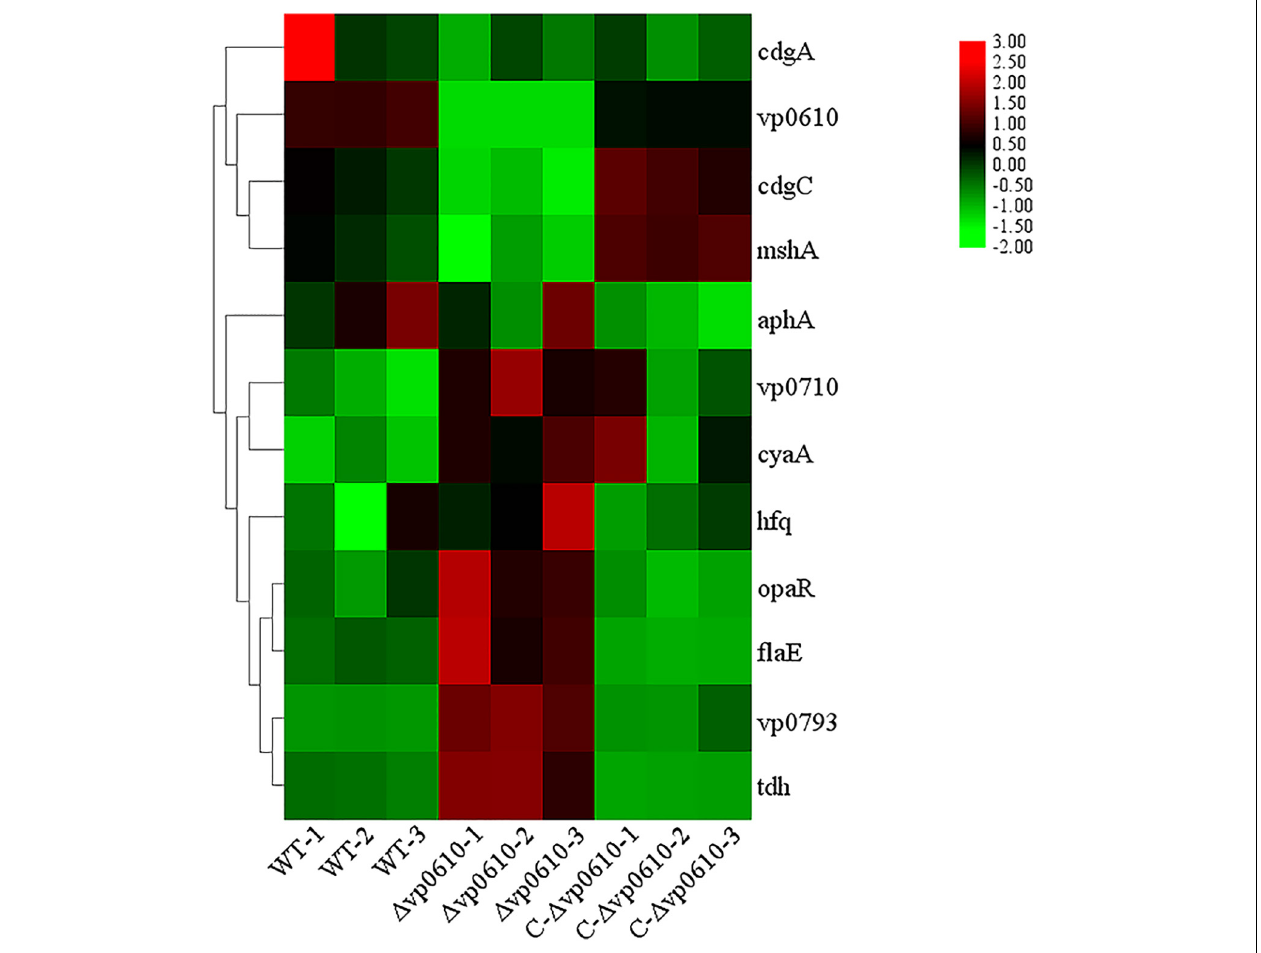
FIGURE 7 | Biofilm-related gene expression analysis. Fold increase biofilm-related gene expression by RT-qPCR respect with WT, (cid:49) vp0610, and C- (cid:49) vp0610. This heat map was drawn by TB tools.